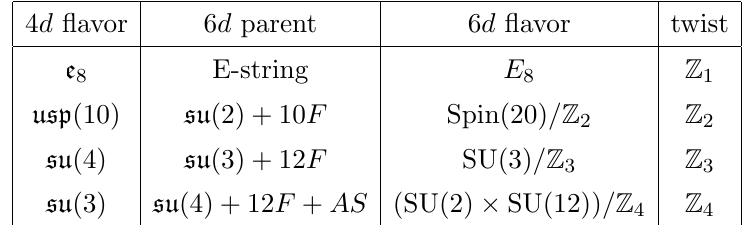
Table 1 . List of 4 d N = 2 rank-1 theories with non-Abelian (cid:13)avor symmetry whose Coulomb branch operator u has dimension 6. Here, k , c , and a are (cid:13)avor and conformal central charges in the standard normalization; the e(cid:11)ective numbers n v , n h of vector multiplets and hypermultiplets are de(cid:12)ned as always by the formula 24 a = 5 n v + n h and 12 c = 2 n v + n h . ( n h ) gen.Coulomb is the Higgs branch dimension at a generic point on the Coulomb branch.